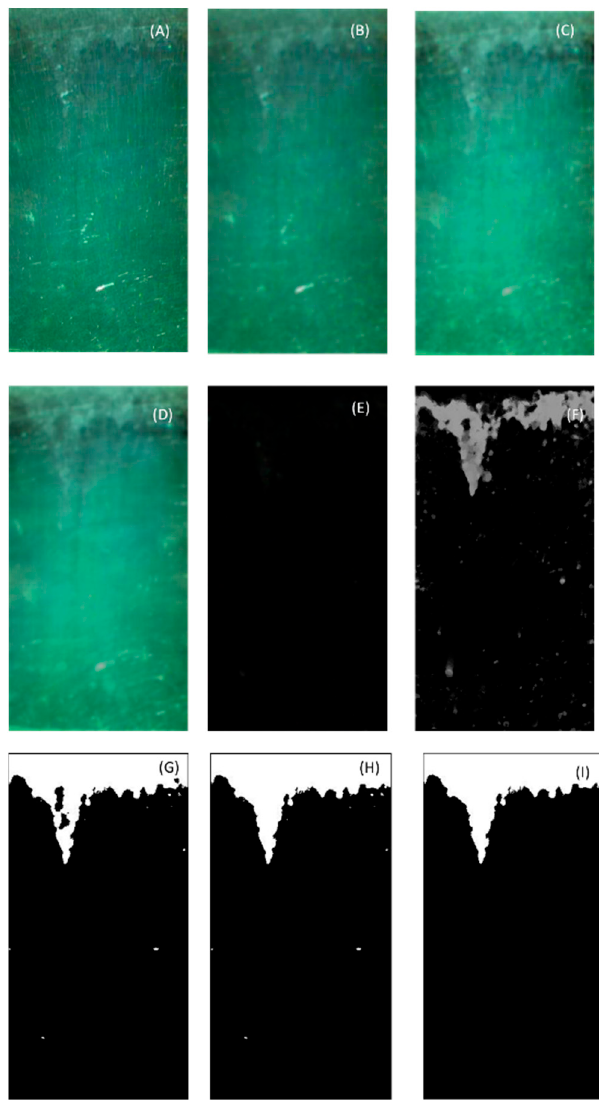
Figure 4. Algorithm of ice detection under light freezing rain: ( A ) original image, ( B ) Gaussian filter, ( C ) Homomorphic filter, ( D ) background, ( E ) difference between the image and the background, ( F ) addition with which has been detected previously, ( G ) binarization, ( H ) fill the holes, and ( I ) largest connected region.